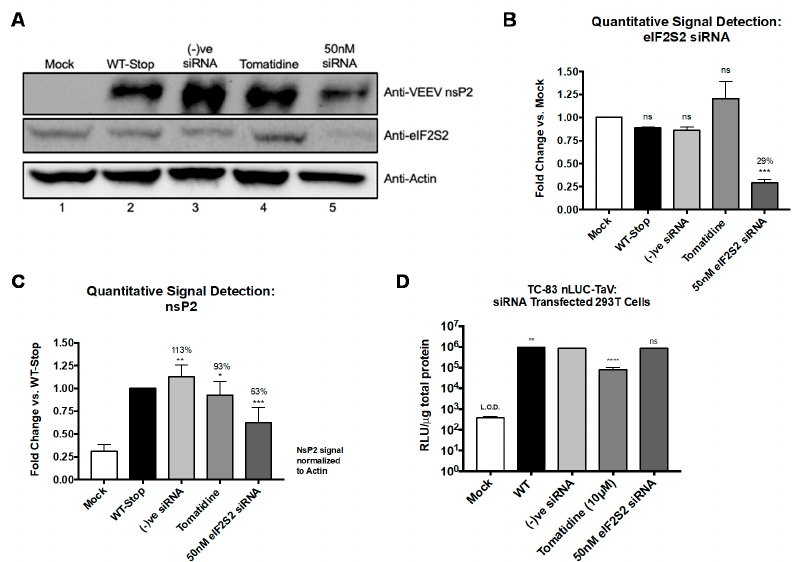
Figure 9. EIF2S2 is important for VEEV genomic RNA but not subgenomic RNA translation. Furthermore, 293 T cells were transfected with 50 nM eIF2S2 or off-target negative siRNA for 72 h or treated with 10 μ M Tomatidine for 2 h. TC-83 genomic RNA containing a mutated stop codon was transfected, as described in Materials and Methods for 24 h. Cellular lysates were probed for eIF2S2 siRNA knockdown ( A , B ), nsP2 as an indicator of genomic translation ( A , C ), as described in Materials and Methods. Signals were quantified and normalized to the actin loading control and fold-change was calculated versus the mock-transfected cells ( B ) or the untreated and non-siRNA transfected WT-Stop control ( C ). Western blot and graphical data are representative of two independent experiments ( n = 2). SiRNA transfected or tomatidine treated 293 T cells were infected in triplicate with a nLUC-TaV expressing TC-83 virus at MOI 0.1 for 24 h, as described in Materials and Methods. ( D ) Cellular lysates were obtained and quantified for luciferase activity and normalized to total protein by Bradford assay for measurement of subgenomic RNA translation, as described in Materials and Methods. Graph is representative of two independent experiments performed in triplicate ( n = 6). * p < 0.0332, ** p < 0.0021, *** p < 0.0002, **** p < 0.0001, ns, not